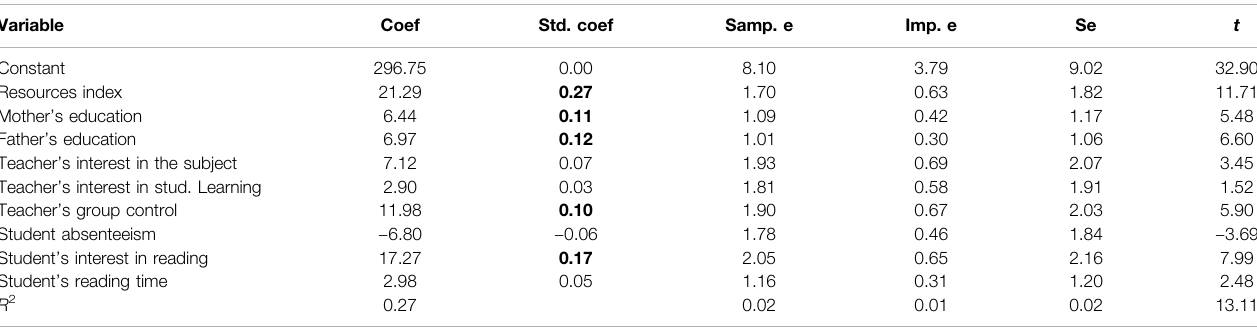
TABLE 2 | Linear regression of the PISA reading literacy scores, using plausible values and sampling weights.